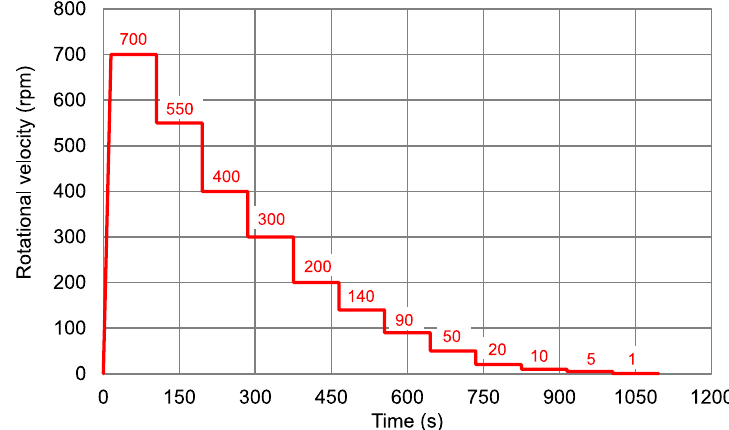
Figure 3. Rotational rheometer profile consisting of different steps of rotational velocity.